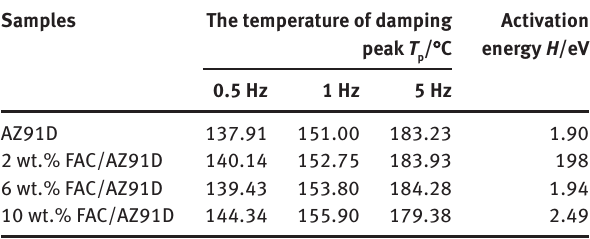
Table 1: Variation of the peak temperature and heat activation energy H in AZ91D Mg alloy and FAC/AZ91D